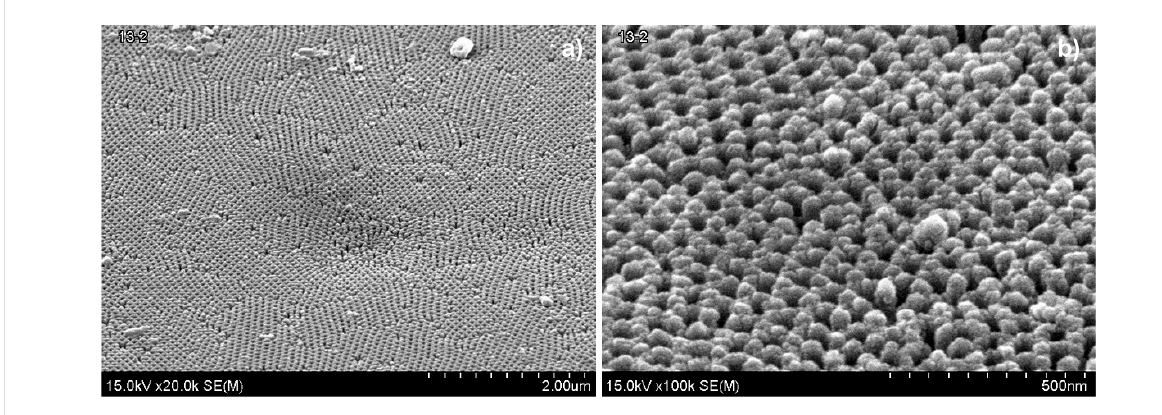
Figure 1: SEM top view of the obtained porous alumina oxide at different magnification a) 20000×, b) 100000×.